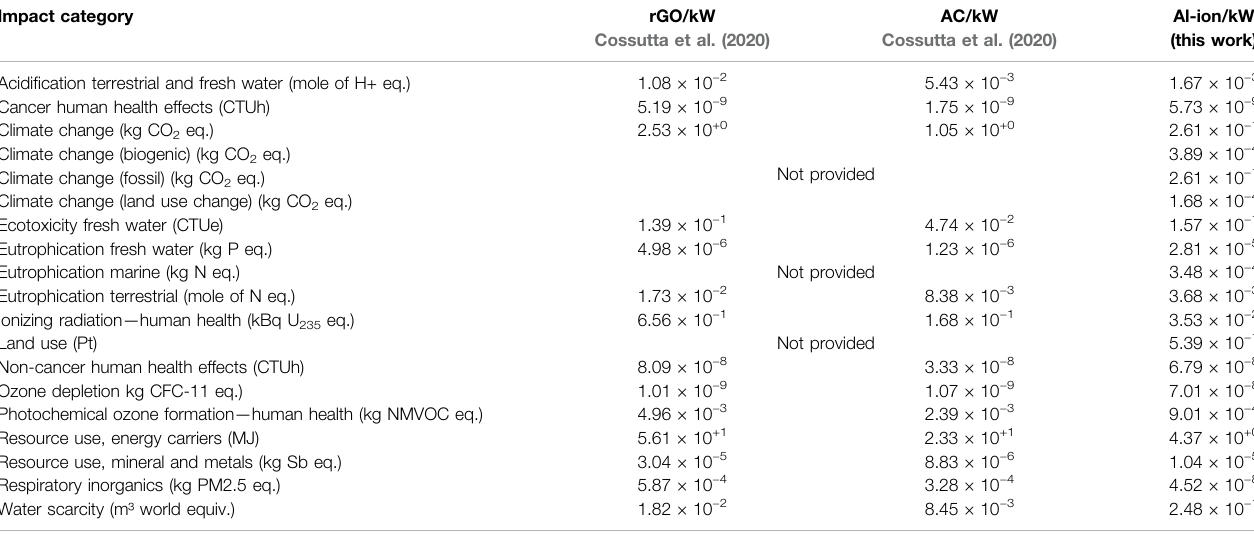
TABLE 4 | Comparison with Graphene (rGO) and activated carbon (AC) supercapacitors per kW with this work. Values calculated from (Cossutta, et al., 2020) supplementary information. Impact category